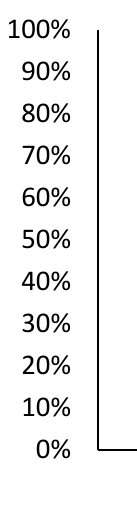
treatments used 1 million infective juveniles per tree. The application was made in a conventional peach orchard in fall 2018 with a reapplication and assessment in spring 2019. Different letters above bars indicate significant differences ( p < 0.05).